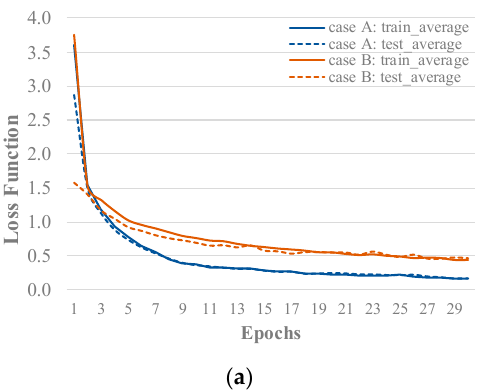
Figure 12. CCE loss graph with five train-test runs of cross-validation for the second case when motor load condition is ignored as input label.